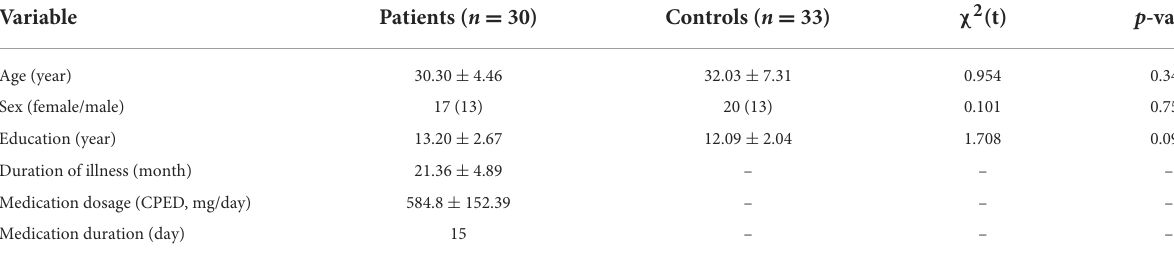
TABLE 1 Demographic and clinical characteristics of the participants.